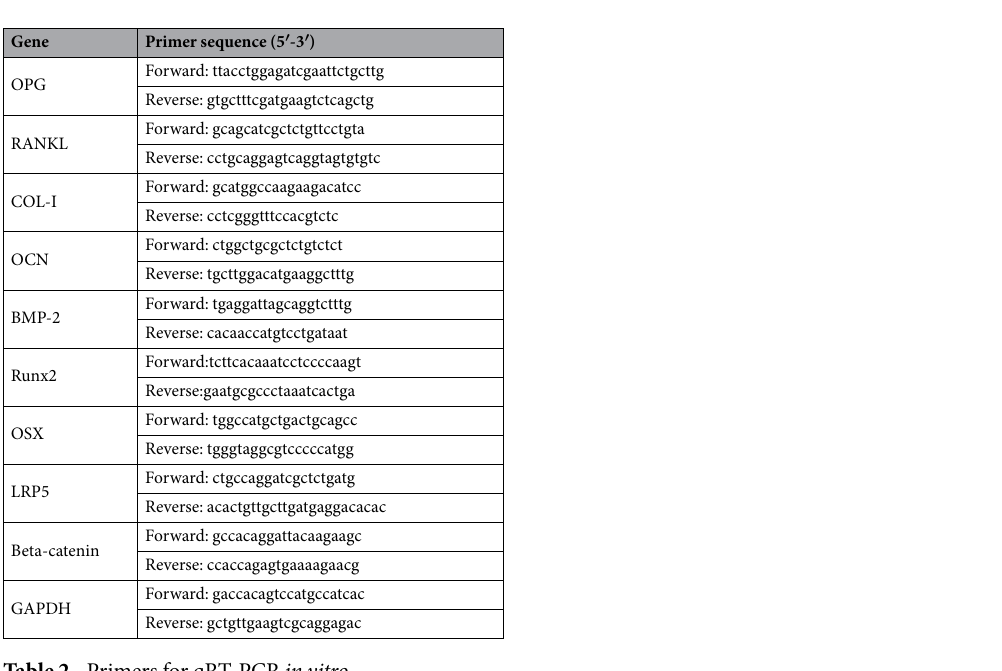
Table 2. Primers for qRT-PCR in vitro